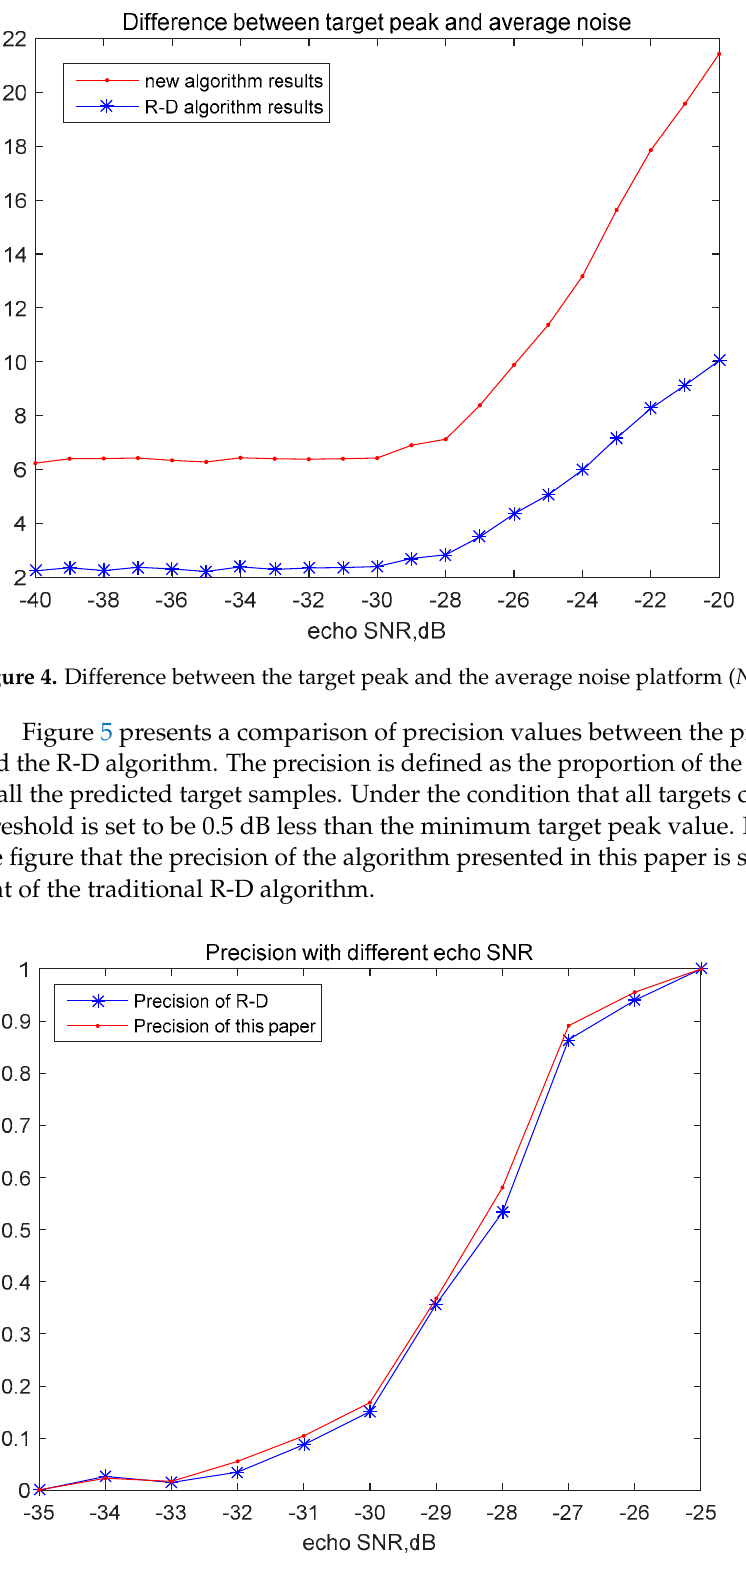
Figure 5. Precision of target detection with different noise power values ( N = 10 4 ). minimum target peak value. It can be seen from the figure that the precision of the algorithm in this paper is much higher than that of the R-D